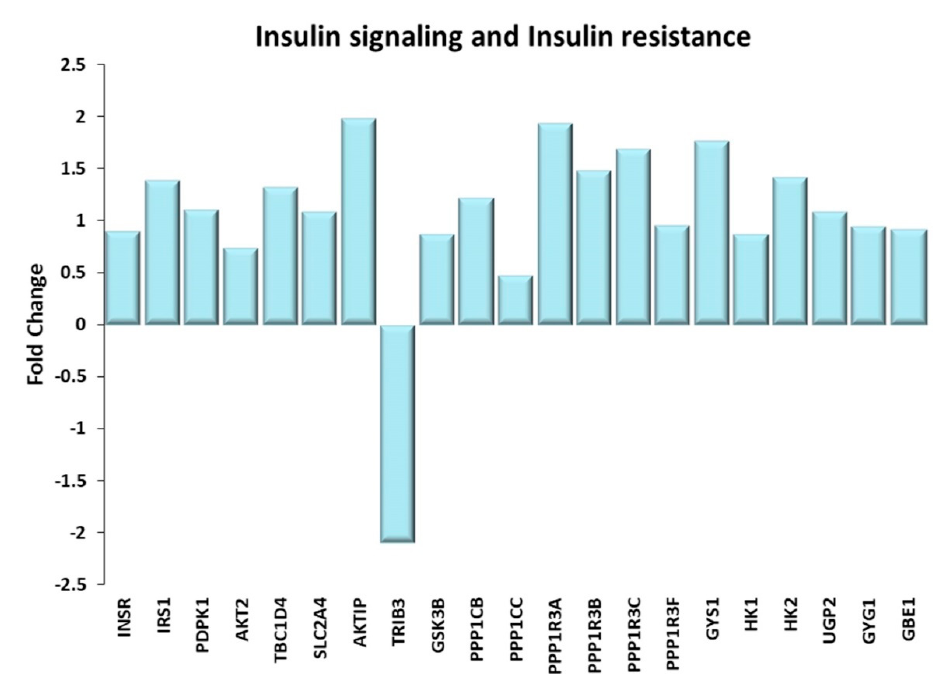
Figure 3. Insulin signaling and Insulin resistance. Genes discussed in the text are shown here as fold change in the comparison of TRA and SED subjects. INSR: Insulin receptor; IRS1: Insulin receptor substrate 1; PDPK1: 3-phosphoinositide dependent protein kinase 1; AKT2: AKT serine / threonine kinase 2; TBC1D4: Akt substrate of 160 kDa or AS160; SLC2A4: glucose transporter type 4 or GLUT-4; AKTIP: AKT interacting protein; TRIB3: tribbles pseudokinase 3; GSK3B: glycogen synthase kinase